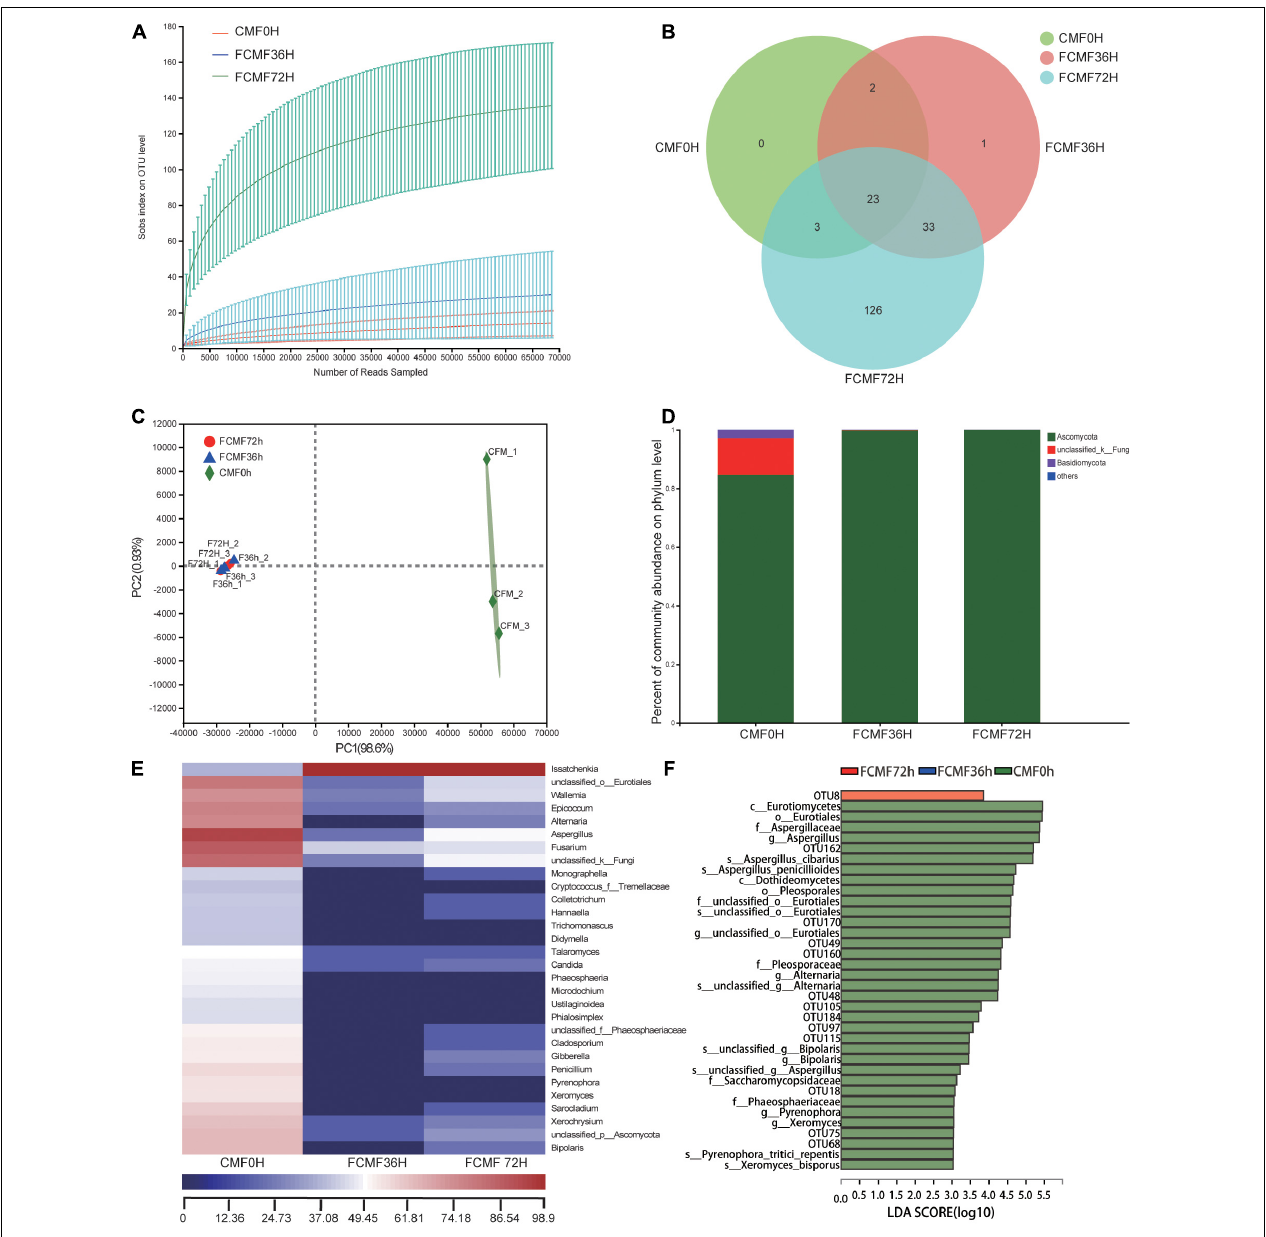
FIGURE 4 | Microbial diversity and fungal community structure during two-stage SSF ( n = 3). (A) Observed OTU line chart. (B) Venn diagram representing the common and unique OTUs found at each fermentation time point. (C) Principal component analyses (PCA) of samples conducted based on unweighted UniFrac distanced. (D,E) Phylum-level (D) and genus-level (E) compositions of the fungal community in FCFM. (F) LEFSe histogram showing the LDA scores ( > 3.0) computed for features at the OTU level. Letters indicate the taxonomy of the bacteria: p, phylum, c, class; o, order; f, family; g,